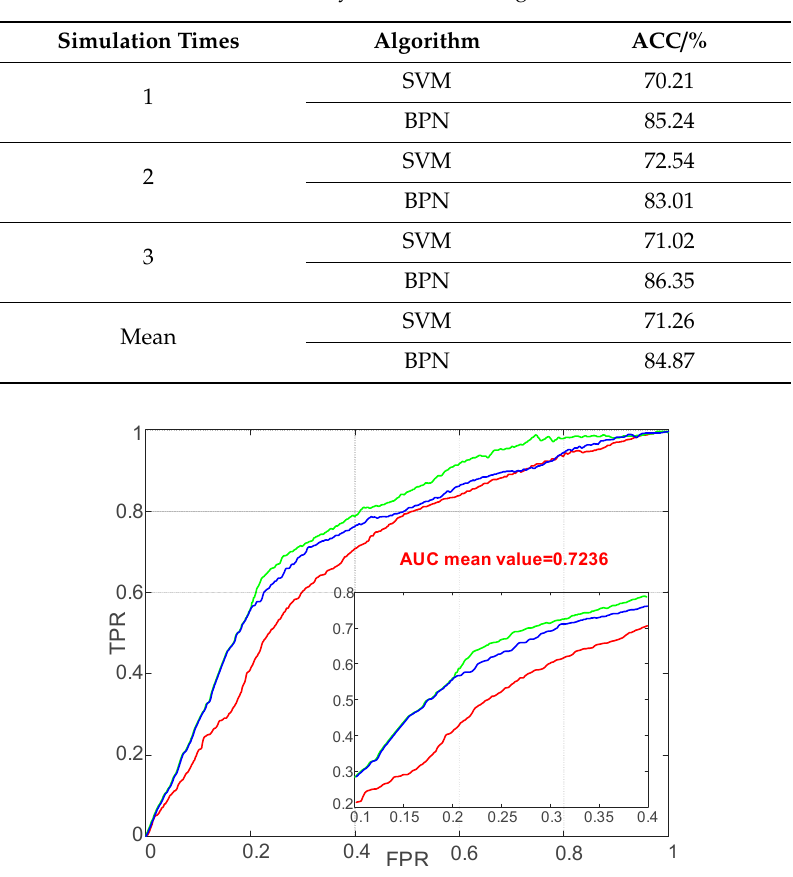
Figure 9. ROC curve detected by support vector machines with K-SMOTE.